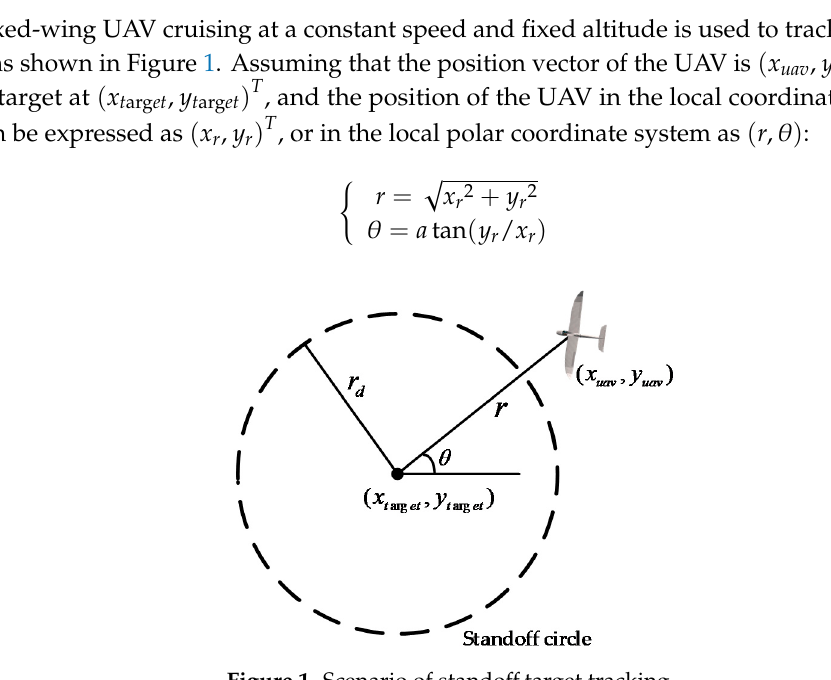
Figure 1. Scenario of stando ff target Figure 1. Sc enario of standoff target tracking.